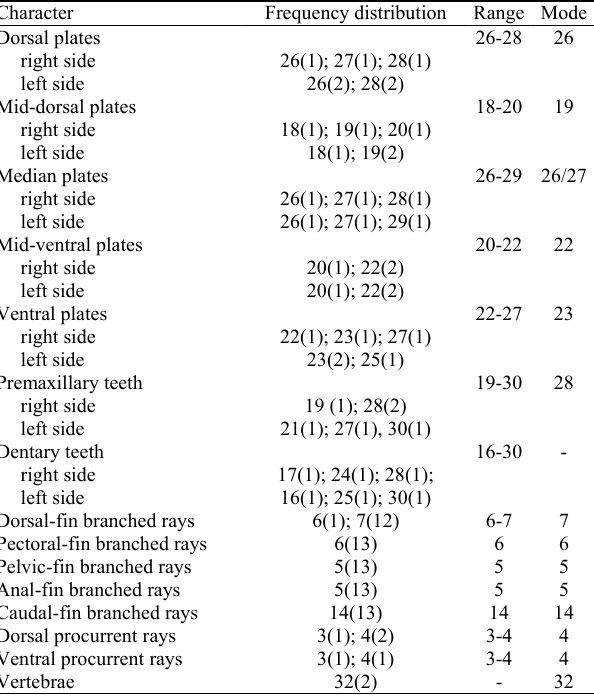
Table 6. Frequency distribution of meristics for Rhinolekos schaeferi (DZSJRP 12192; MCP